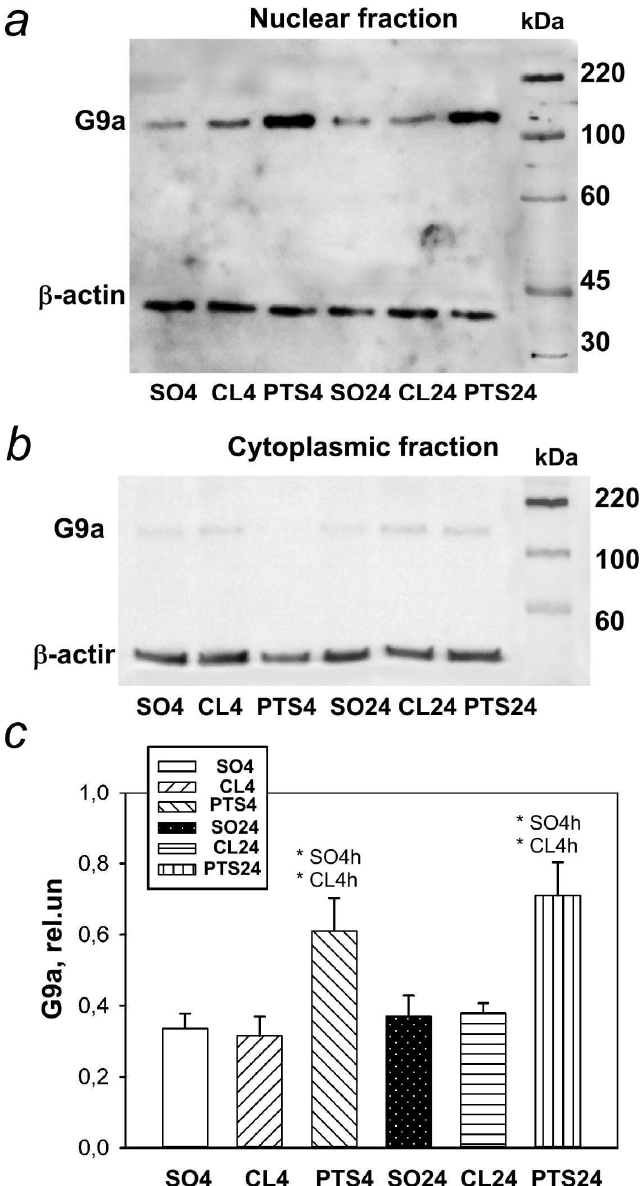
Figure 7. G9a expression in nuclear ( a , с ) and cytoplasmic ( b ) fractions of penumbra tissue 4 or 24 h after photothrombotic stroke (PTS) in the cerebral cortex of rats. * p < 0.05 compared to sham-operated animals (SO) or contralateral cerebral (CL) cortex of the same animals. One-way ANOVA. M ± SEM. n = 7. Rel.un—the ratio of the optical density of the strip of the protein studied to the optical density of the strip of the protein load marker (actin).